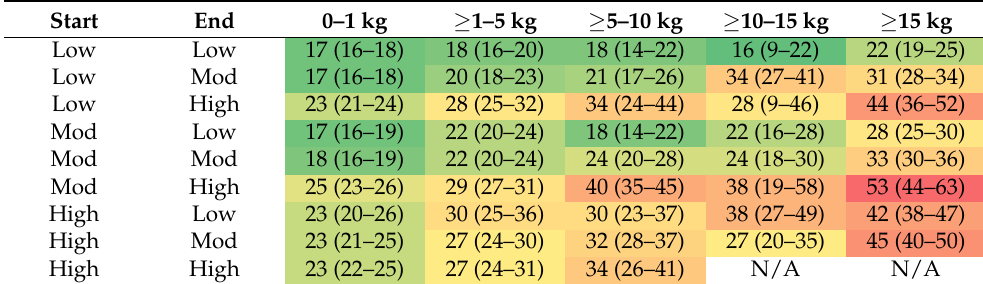
Table 5. Muscular workload of the neck/shoulders arranged by load mass and start and end position of the lift. The interaction between start and end position for muscular workload was statistically significant. Estimates are presented as % nEMG (95%